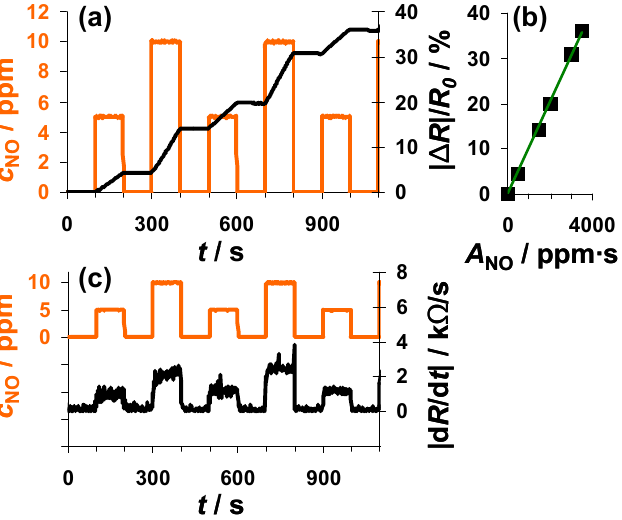
Figure 5. Sensor response on pulses of three times 5 ppm and two times 10 ppm NO for 100 s